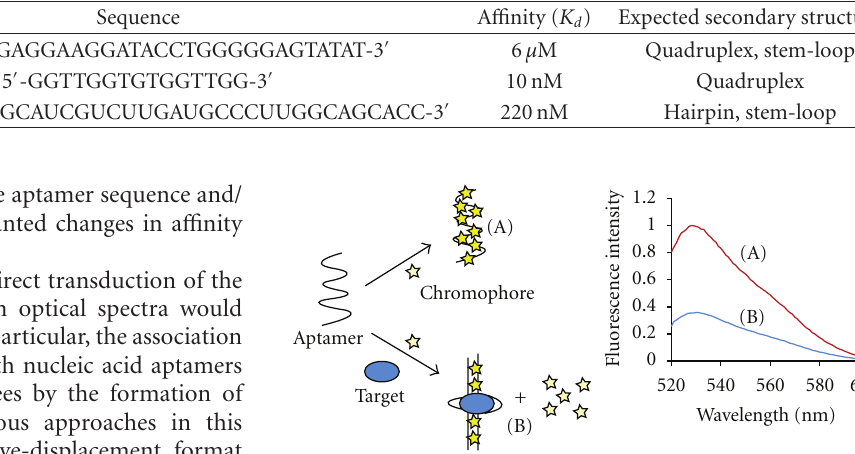
Figure 1: Strategy for using nucleic acid binding chromophores as indicators of aptamer-target interactions. The plot on the right shows fluorescence spectra of Thiazole Orange (TO) in complex with the theophylline aptamer (A) in the absence and (B) presence of